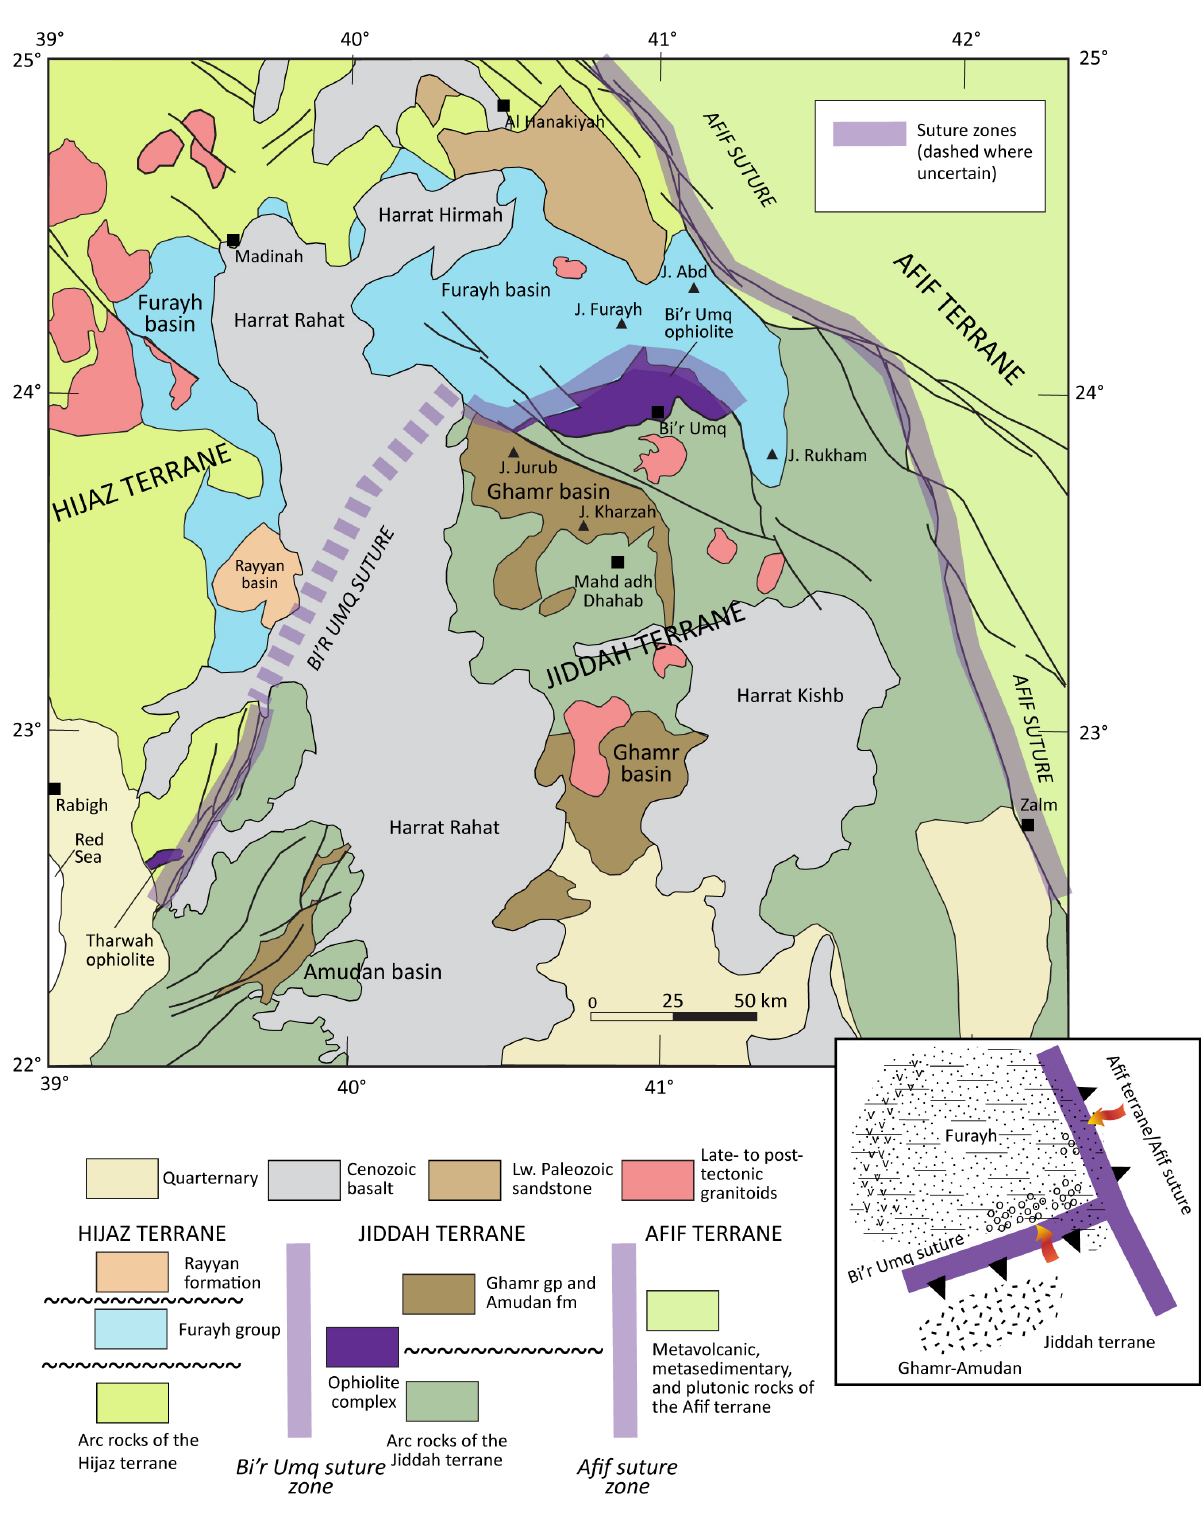
Figure 5. Geologic map of the Ghamr group and Amudan formation and Furayh group (after [24,25]) showing their locations in basins unconformable on arc rocks of the Jiddah and Hijaz terranes, south and north of the Bi’r Umq suture, respectively. Inset schematically shows the tectonic settings of the basins in relationship to the Bi’r Umq and Afif suture zones. Arrows suggest sites of influx of coarse conglomeratic